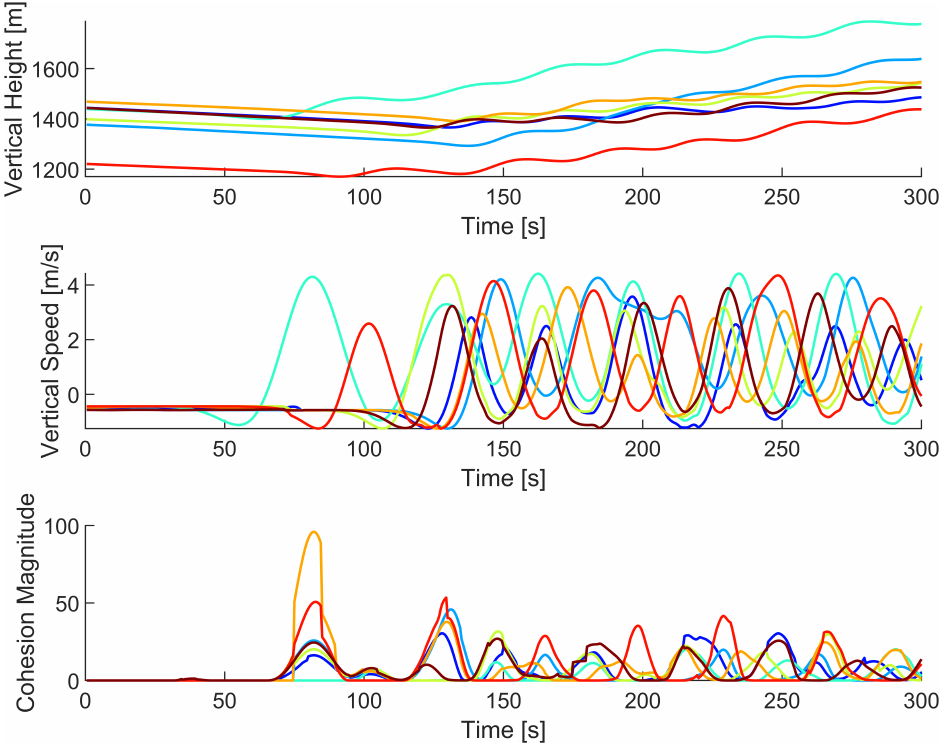
Figure 10. Vertical position, vertical speed, and cohesion magnitude data of a group of agents as they discover and exploit a thermal updraft. The included agents are agents 7, 13, 19, 21, 28, 30, and 36, chosen due to their close proximity and exploitation of the chosen thermal updraft. The data only covers the first 300 s of the